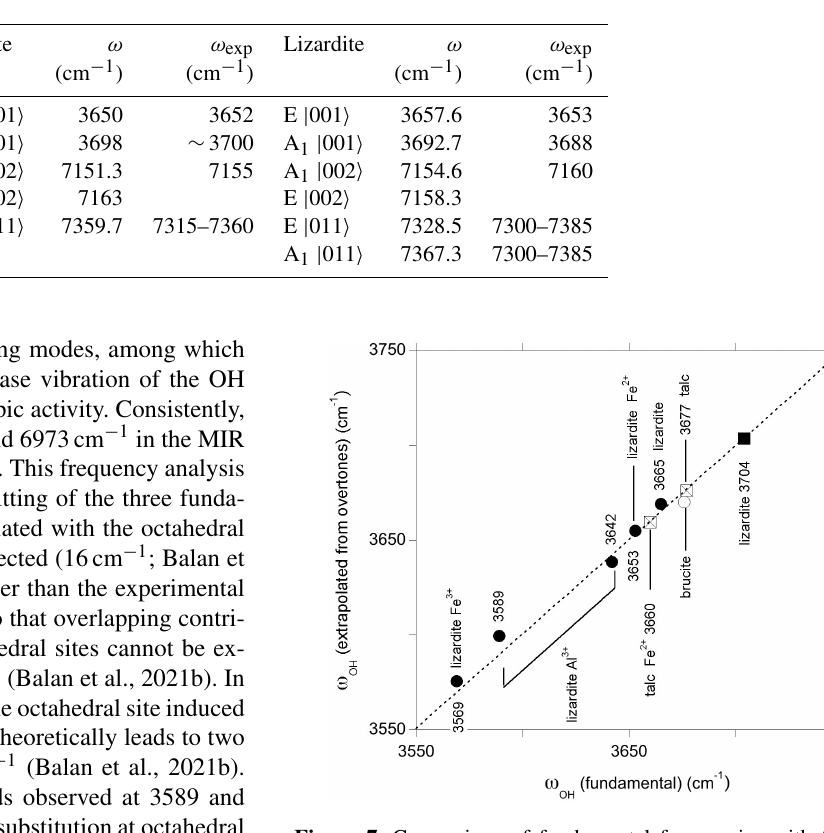
Table 6. Frequencies of interlayer OH stretching fundamental and first overtone transitions in brucite and lizardite obtained using the effective Hamiltonian of Balan et al. (2021a). The transitions are labeled by the symmetry and the ket of the dominant contribution to the final state. The frequencies are compared with their experimental counterparts. The local transitions to | 11 (cid:105) type states actually correspond to the two-phonon continuum.